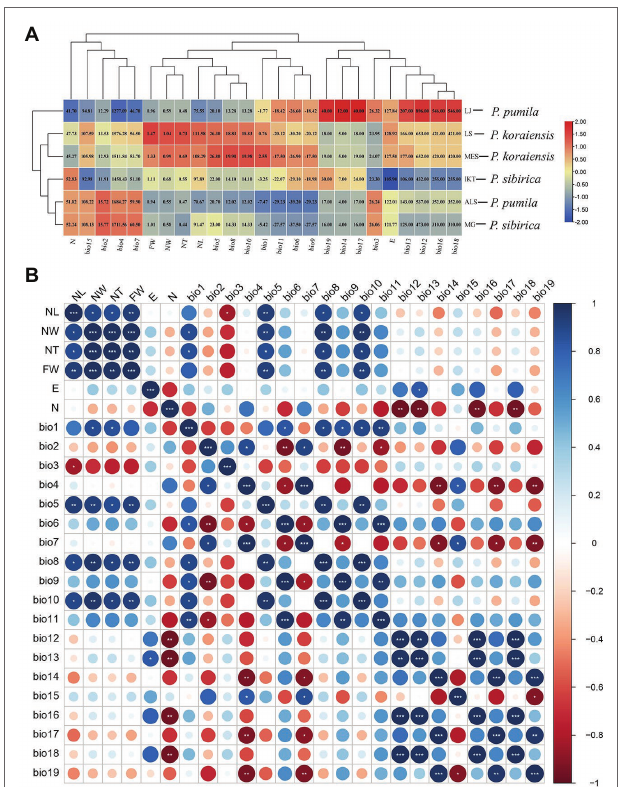
FIGURE 2 | Correlation between needle traits and climate factors in the three five-needle pines. (A) Heatmap and cluster analysis of needle traits and climate factors in natural populations of Pinus koraiensis , Pinus sibirica , and Pinus pumila . The number in heatmap indicates the specific size of variables. (B) Correlation analysis of 25 characteristic related to needle traits and climate factors. The analysis was performed using R software. One asterisk (*) indicates the p < 0.05; two asterisks (**) means p < 0.01; and three asterisks (***) means p < 0.001. The circle from small to large indicates the corresponding correlation coefficient from low to high. The color scale of red and blue refers to negative correlations and positive correlations, respectively. NL, needle length; NW, needle width; NT, needle thickness; FW, fascicle width; E, longitude; N, latitude; bio1, annual mean temperature; bio2, diurnal temperature difference; bio3, isothermality; bio4, seasonal variance of temperature; bio5, extreme high temperature; bio6, extreme low temperature; bio7, temperature year difference; bio8, mean temperature in the wettest season; bio9, mean temperature in the most dry season; bio10, mean temperature in the warmest season; bio11, mean temperature in the coldest season; bio12, annual precipitation; bio13, precipitation in the wettest month; bio14, precipitation in the most dry month; bio15, variance coefficient of seasonal precipitation; bio16, precipitation in the wettest season; bio17, precipitation in the most dry season; bio18, precipitation in the warmest season; and bio19, precipitation in the coldest